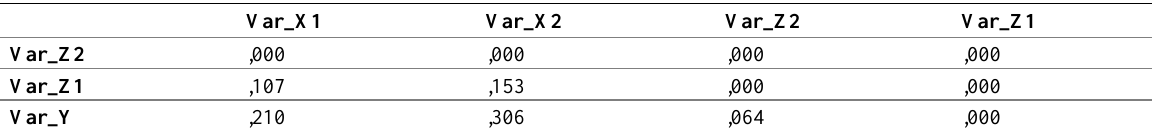
Table 3: Standardized Indirect Effects